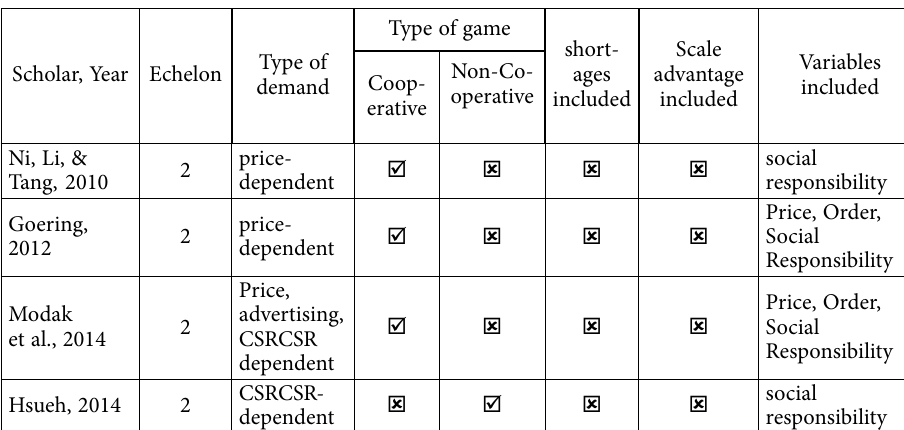
Table 3. Related Research